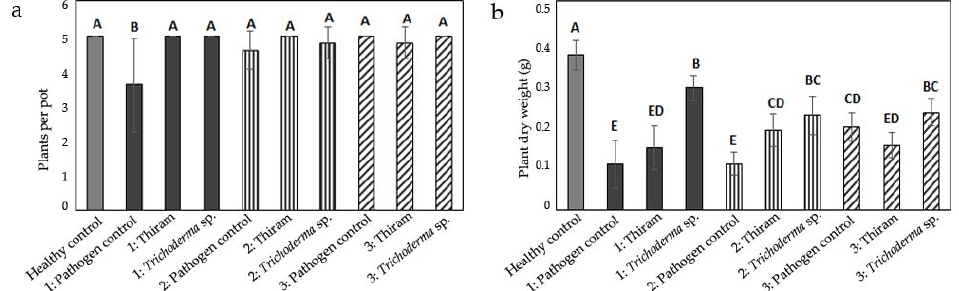
Figure 3. Effect of position of inoculum of Rhizoctonia solani on ( a ) number and ( b ) biomass of maize seedlings and on efficacy of seed treatment with thiram or a suspension of conidia of Trichoderma sp. BI 7376. Variant 1: R. solani inoculum mixed homogenously in the entire pot volume; variant 2: R. solani inoculum present only in the upper half of pots; variant 3: R. solani inoculum present only in the lower half of pots. Means and standard deviation of five pots per treatment with five maize seeds each. Different letters above bars indicate statistically significant differences between the treatments (GLMM; p <